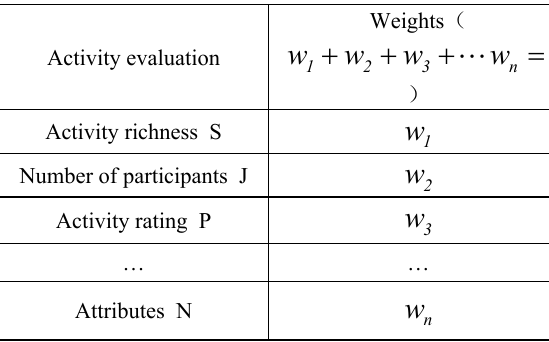
Table 2 Evaluation criteria for quality